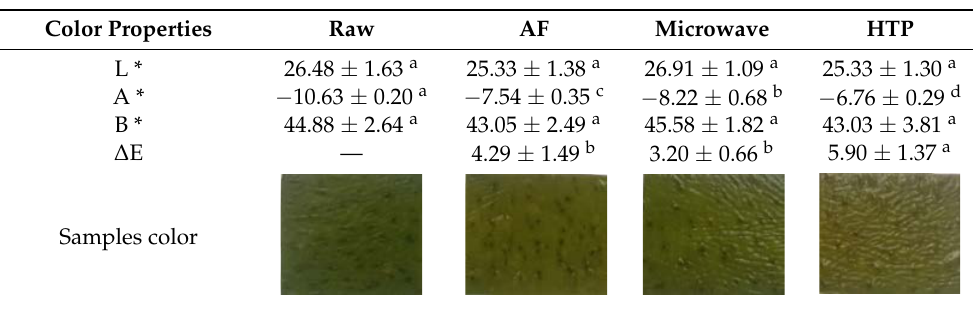
Table 1. Effect of different types of domestic cooking techniques on color properties of Undaria pinnatifida ( UP) .